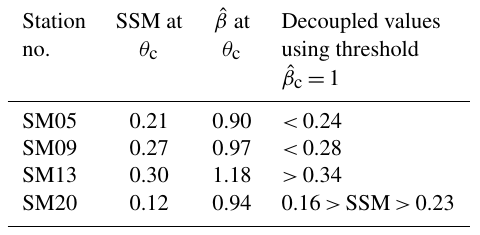
Table 2. List of surface soil moisture values (SSM in cm 3 cm − 3 ) obtained from Figs. 5 and 8. SSM at θ c in Fig. 5 were used to de- termine ˆ β in Fig. 8. A common threshold ˆ β c was used for all sites since ˆ β are all close to 1. The resulting decoupled SSM values are shown in the fourth column.